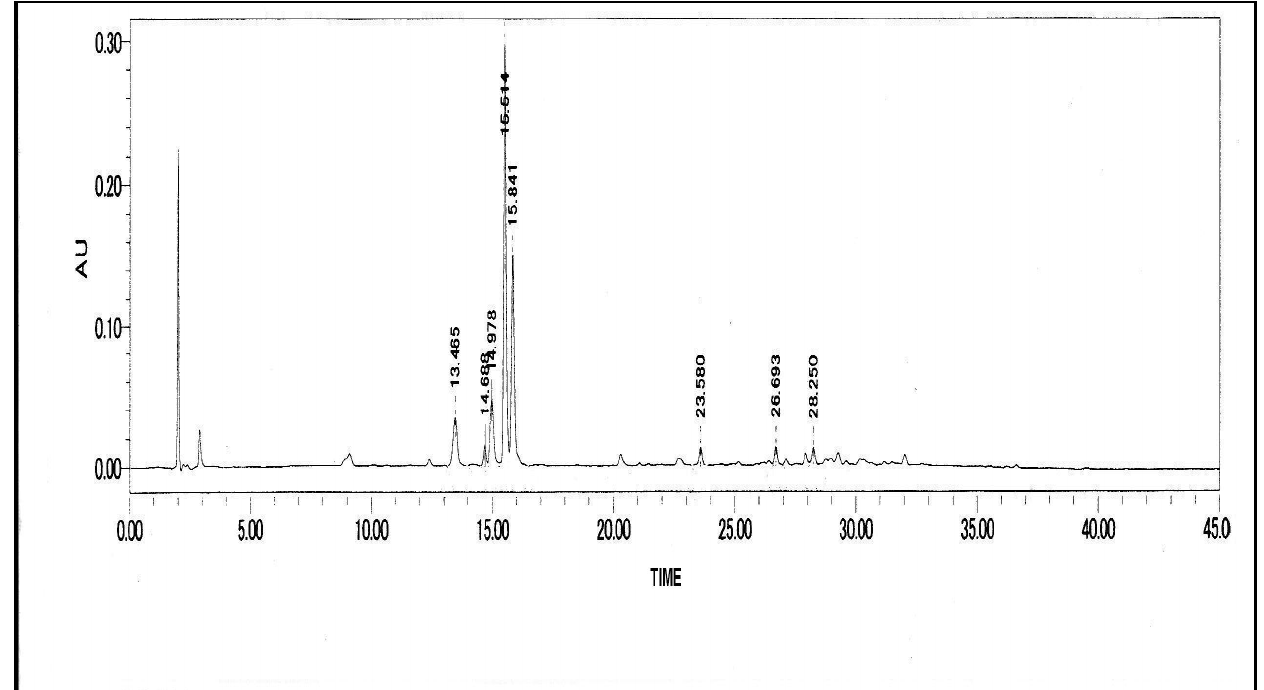
Figure 3. HPLC chromatogram of active fraction isolated from seeds extract of Cassia fistula.